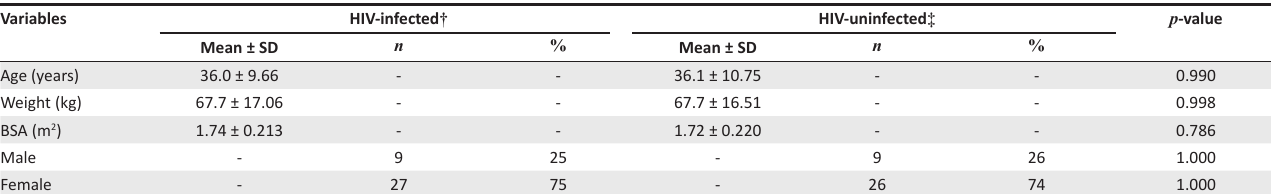
TABLE 1: Clinical data.